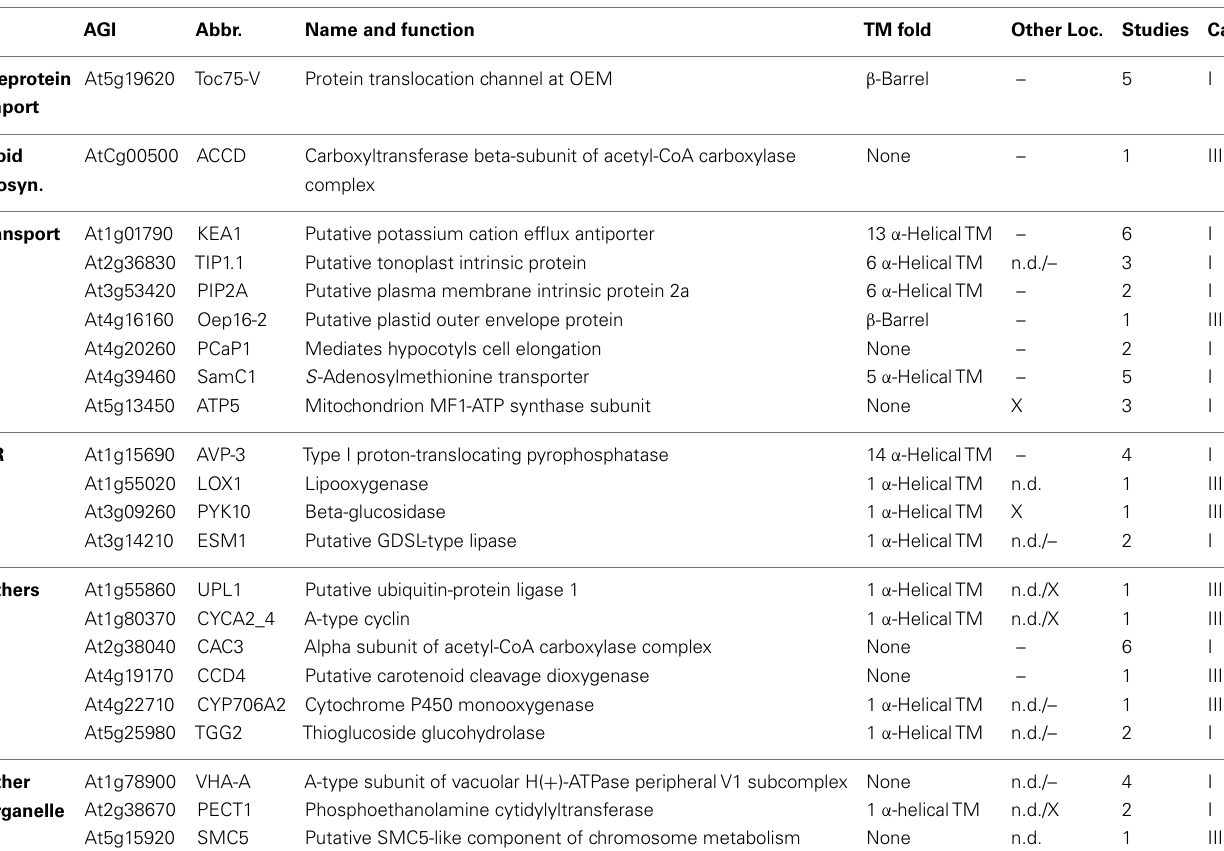
Table 5 | Mixed envelope proteins with known